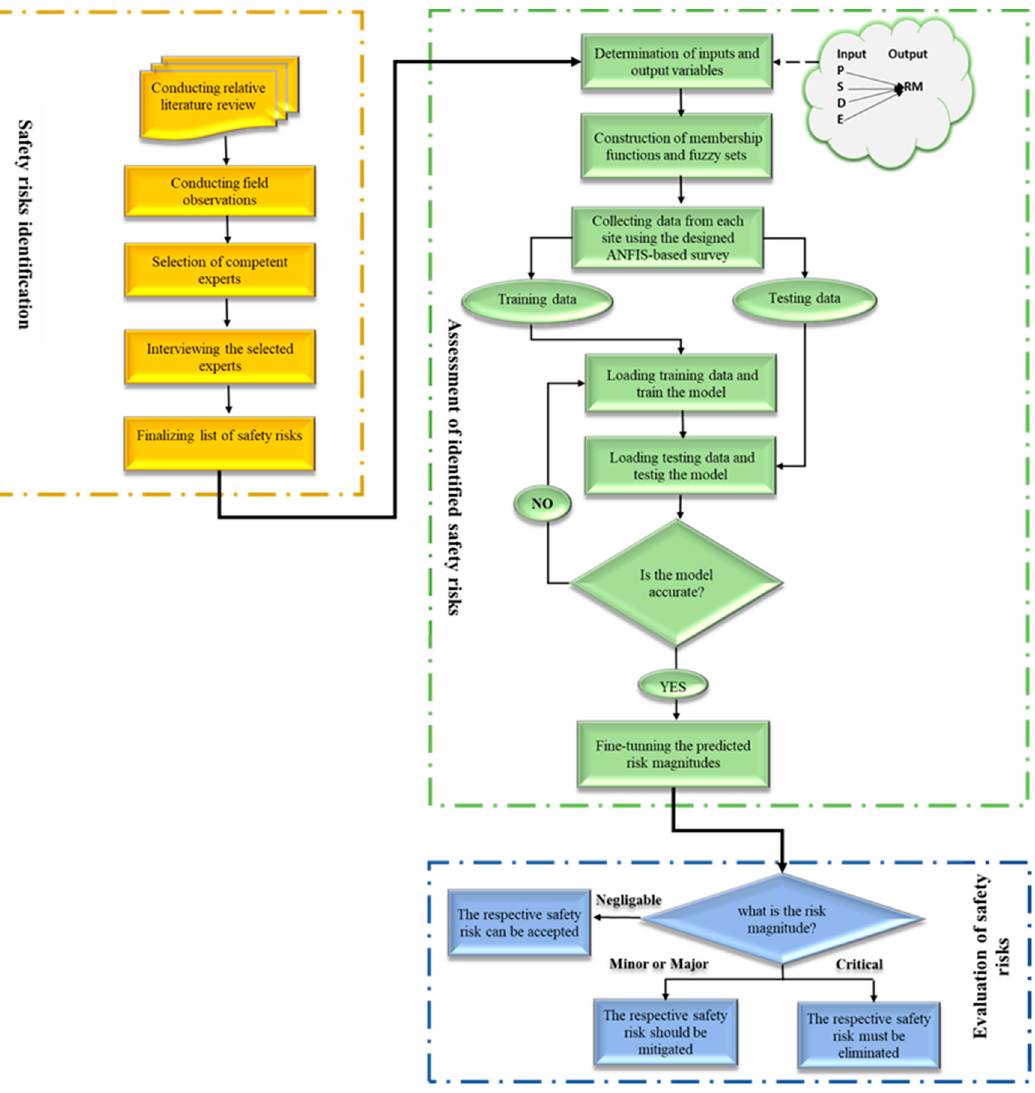
Figure 1. The developed EPRAM.